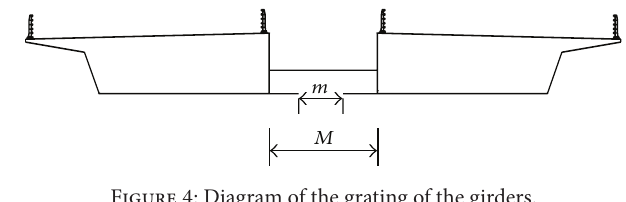
Figure 4: Diagram of the grating of the girders.